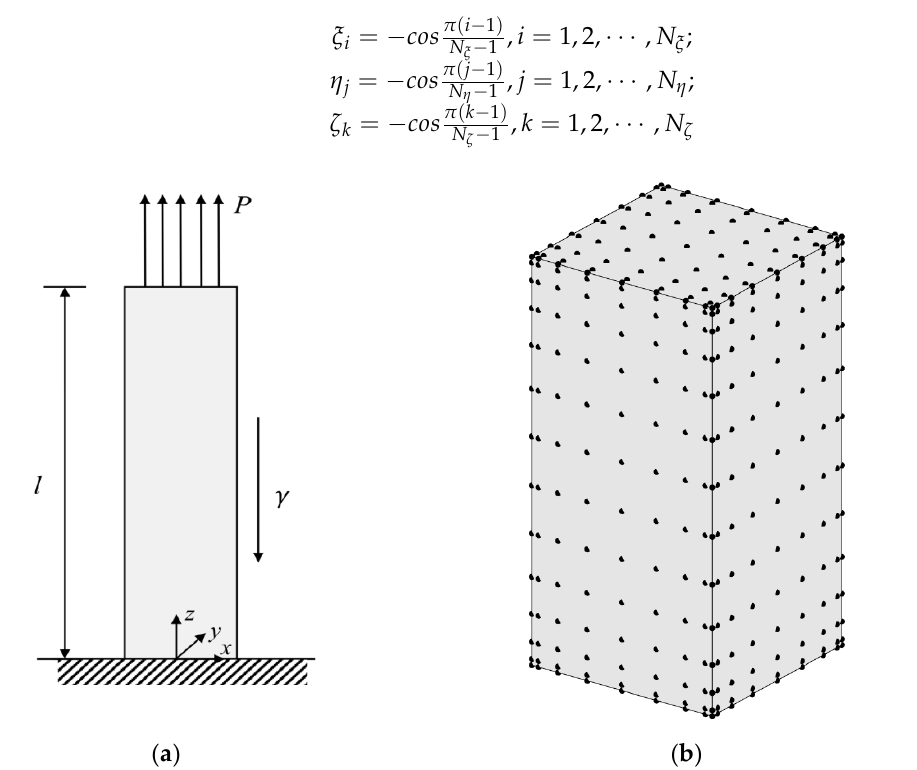
Figure 5. Model with a tensile load and gravity: ( a ) front view of model with load and constraint; ( b ) node distribution in physical domain for FBM. Table 1. Comparison of precision and convergence.